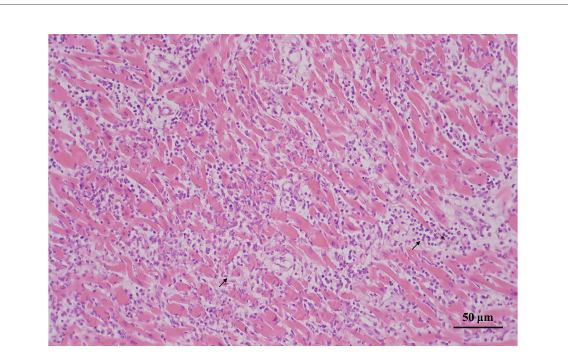
FIGURE1 Myocardial degeneration and necrosis; myocardial interstitium is mainly infiltrated by lymphocytes and monocytes